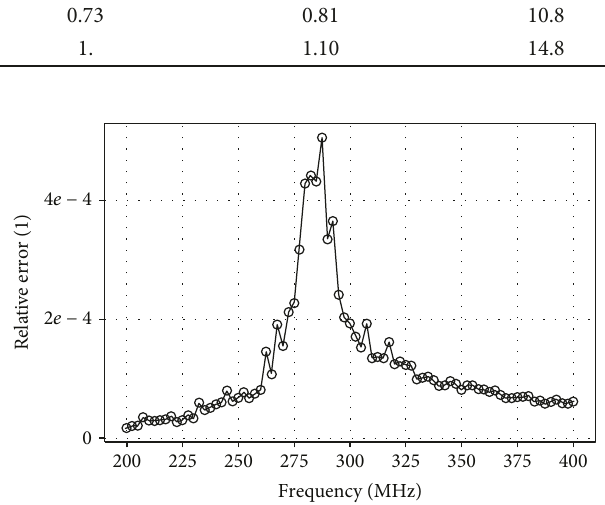
Figure 4: The relative error of the S -parameters between the results of the proposed method and the traditional